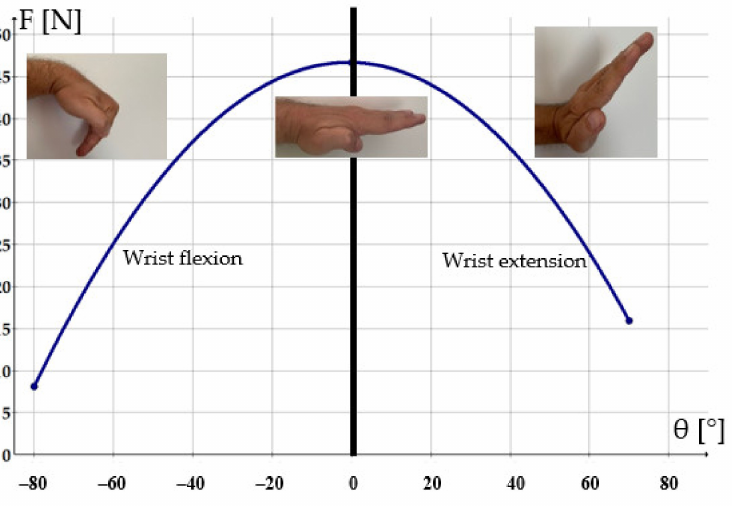
Figure 8. Variation of the force to be developed by the pneumatic muscle along with the rotation of the hand